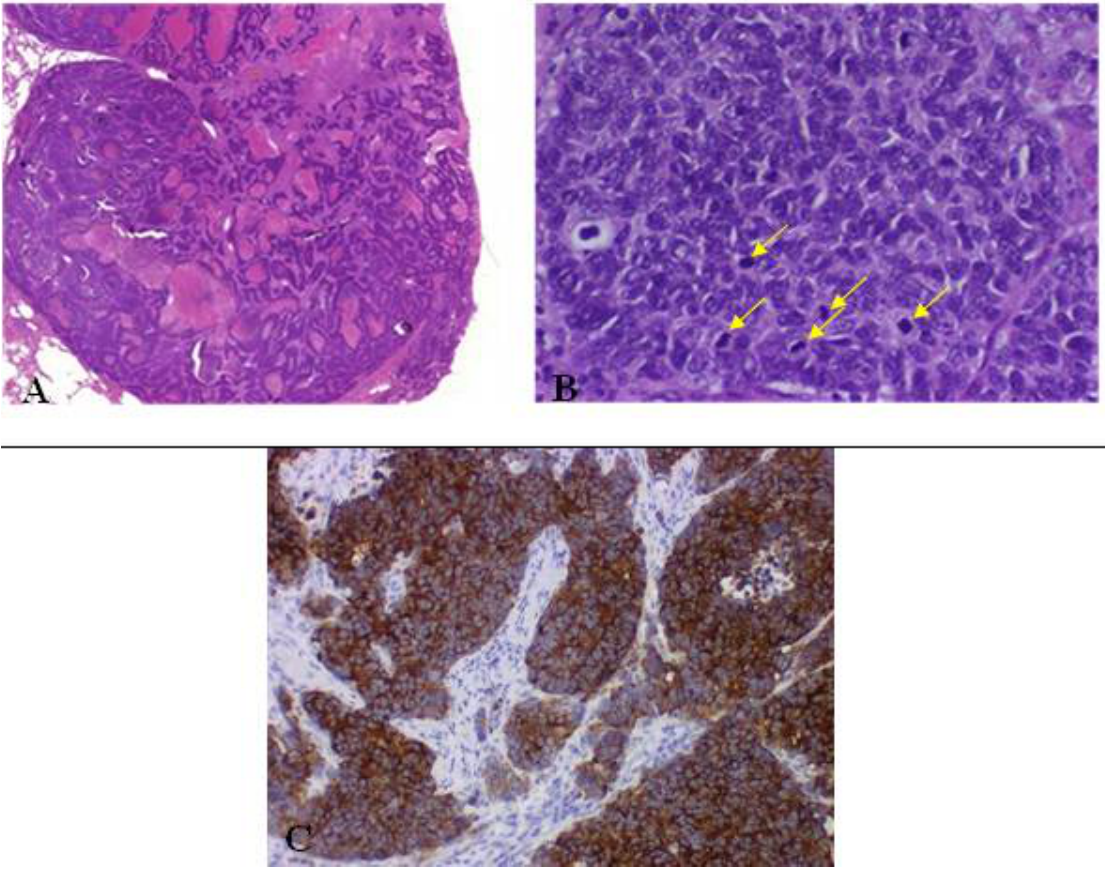
Figure 9. ( A ) Large cell neuroendocrine carcinoma with organoid nesting, trabecular growth, perilobular palisading patterns; ( B ) Tumor cells are large, nucleoli are